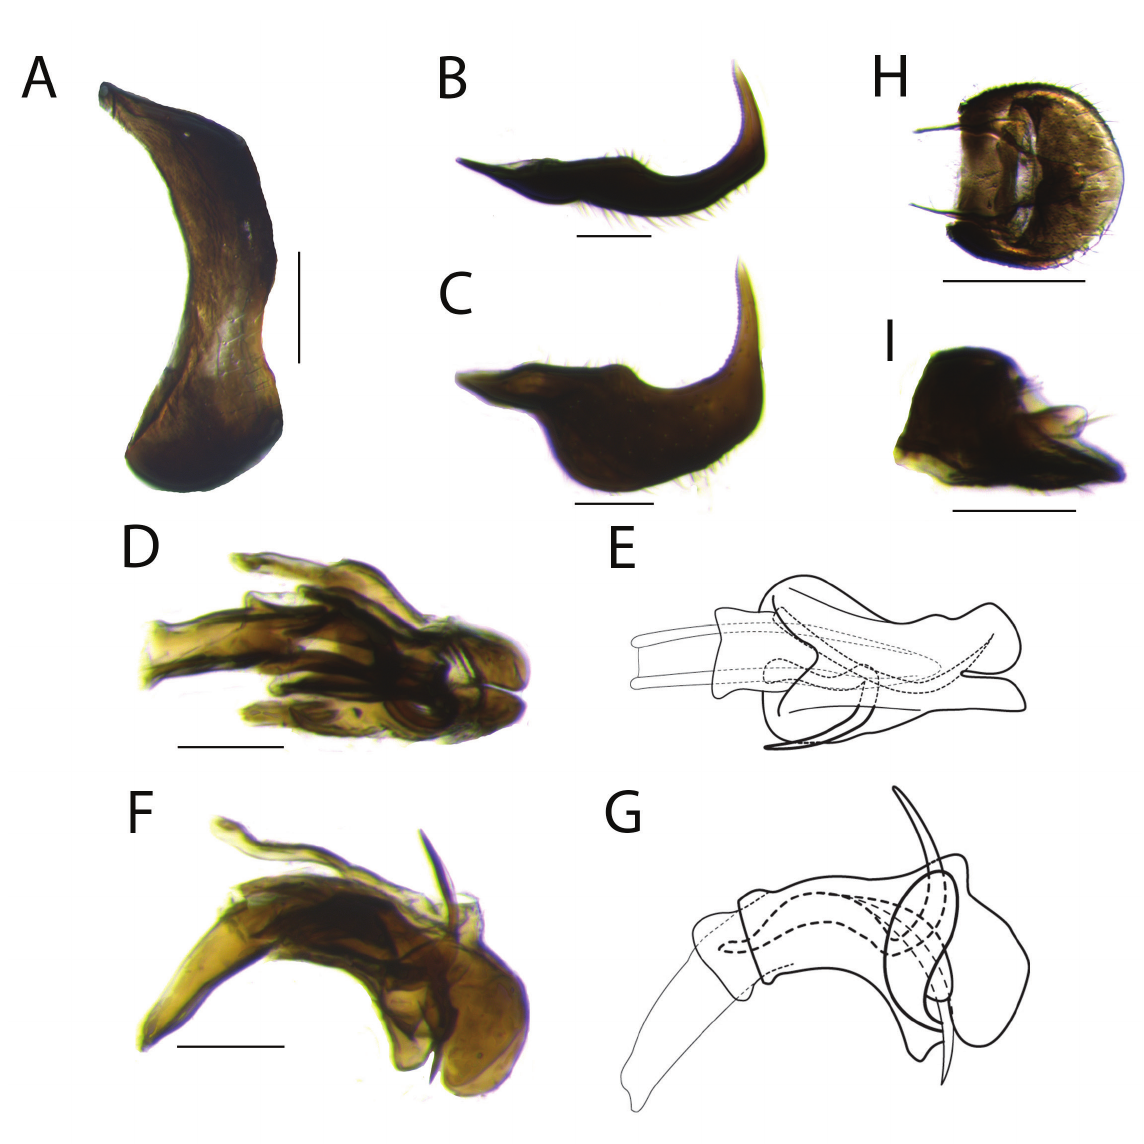
Fig. 12. Male terminalia of Fitchiella brachyrhina sp. nov., holotype (INHS). A . Pygofer, lateral